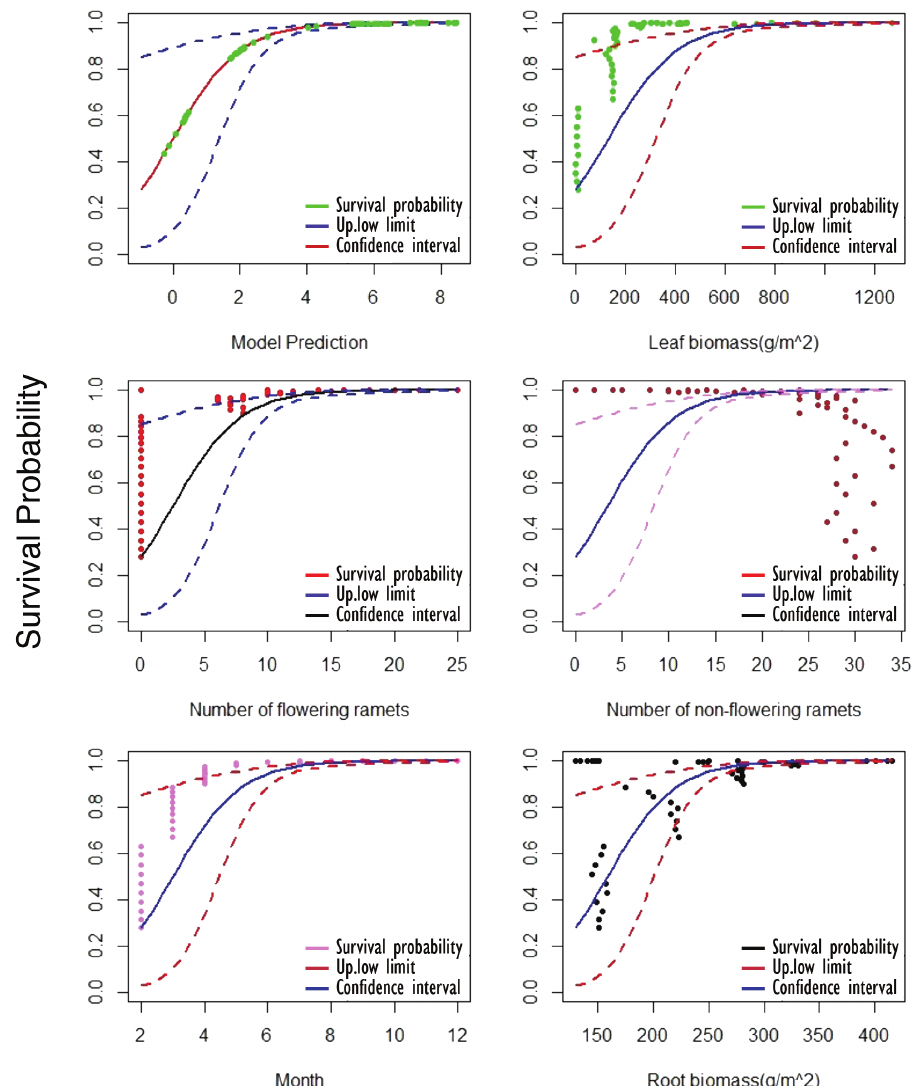
Figure 2. The relationship between survival probability and predictors from the top model for Canal bank